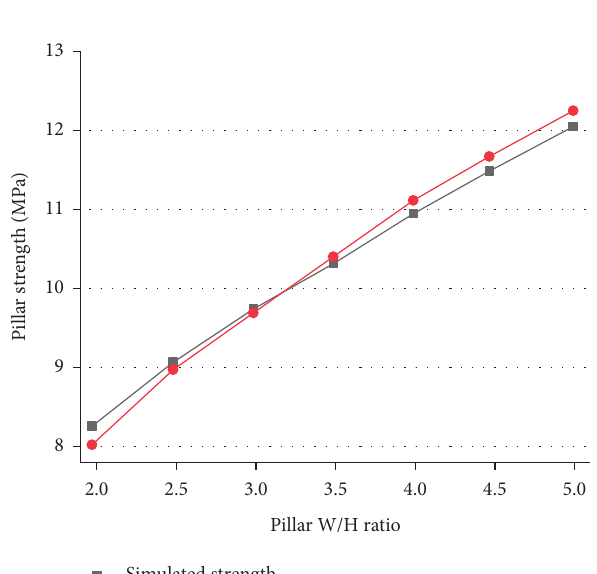
Figure 11: A pillar